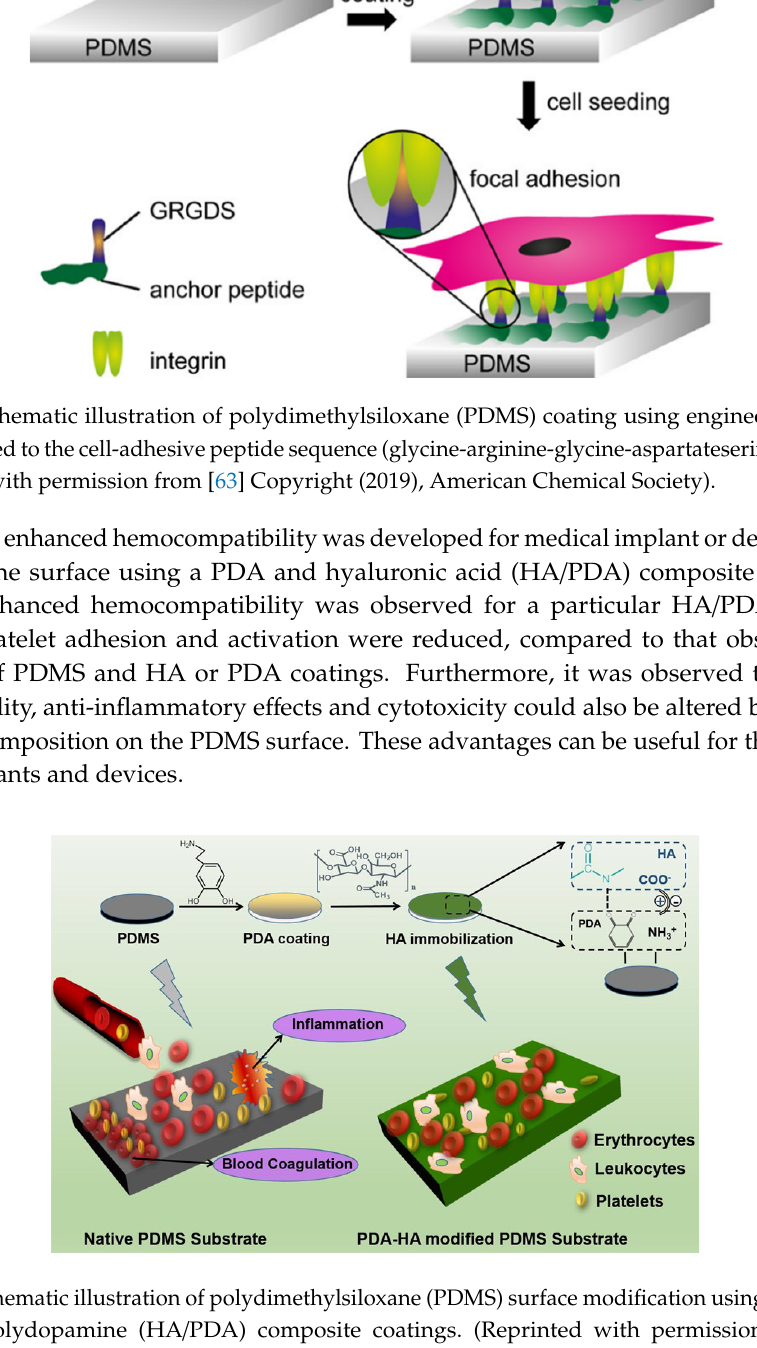
Figure 6. Schematic illustration of polydimethylsiloxane (PDMS) coating using engineered anchor peptides fused to the cell-adhesive peptide sequence (glycine-arginine-glycine-aspartateserine, GRGDS). (Reprinted with permission from [63] Copyright (2019), American Chemical Society).